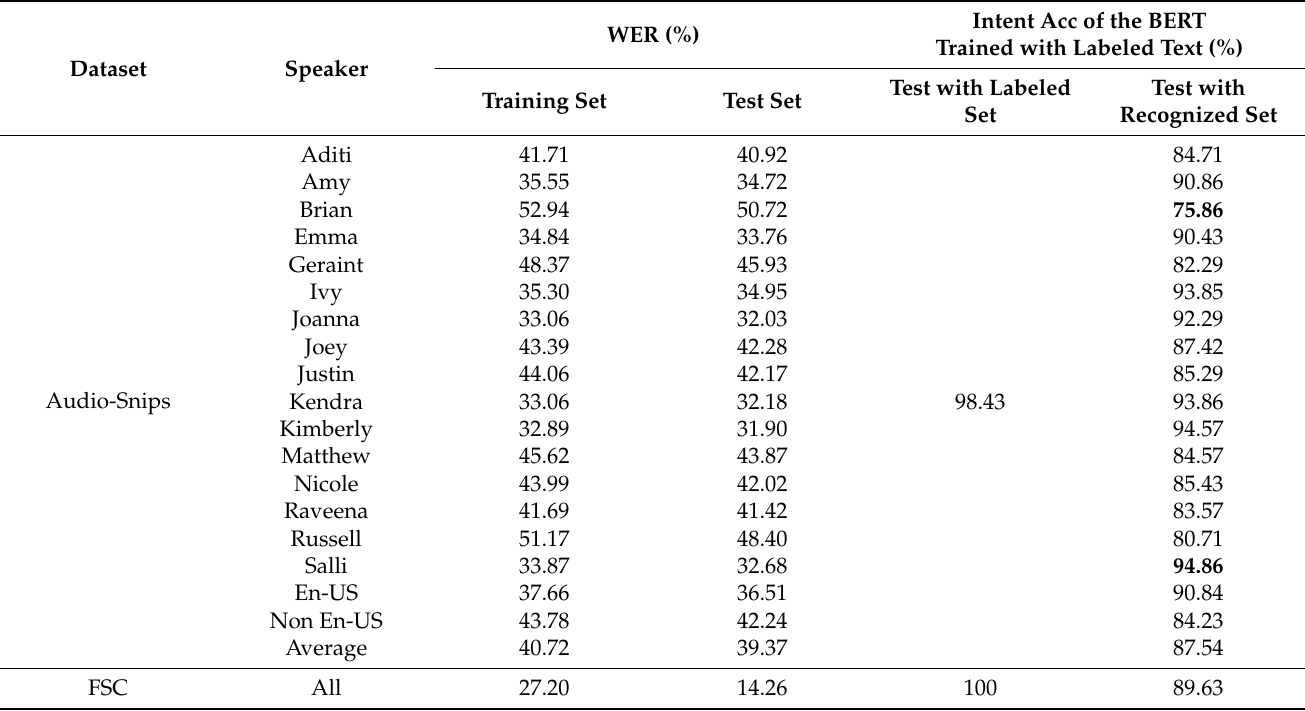
Table 3. Observations of correlations between recognized errors (WER) and intent classification per- formance. Each intent accuracy (Acc) in table was obtained by the BERT model that was trained with labeled training text and evaluated with the test set of each labeled and recognized text,